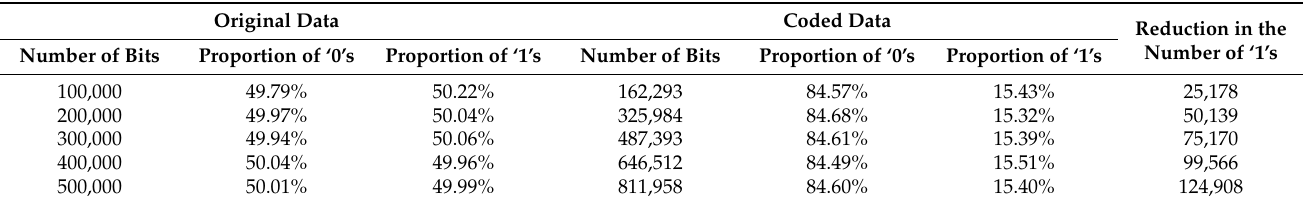
Table 1. Comparison between the original data and the coded data.